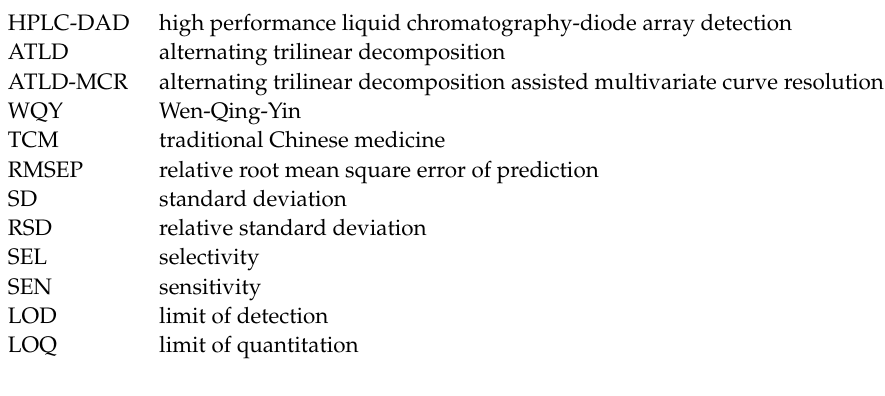
Table S3: The ranges of elution time and spectral wavelength in the two subregions for the five target analytes, the number of estimated factors for exact decomposition of the three-way array using the ATLD and ATLD-MCR algorithms; Table S4: The linear range of five target analytes, regression equation and correlative coefficient (r); Table S5: The spiked concentration and recoveries of the six prediction samples and the p values; Table S6: The concentrations of five analytes in another two WQY commercial products obtained from ATLD-MCR